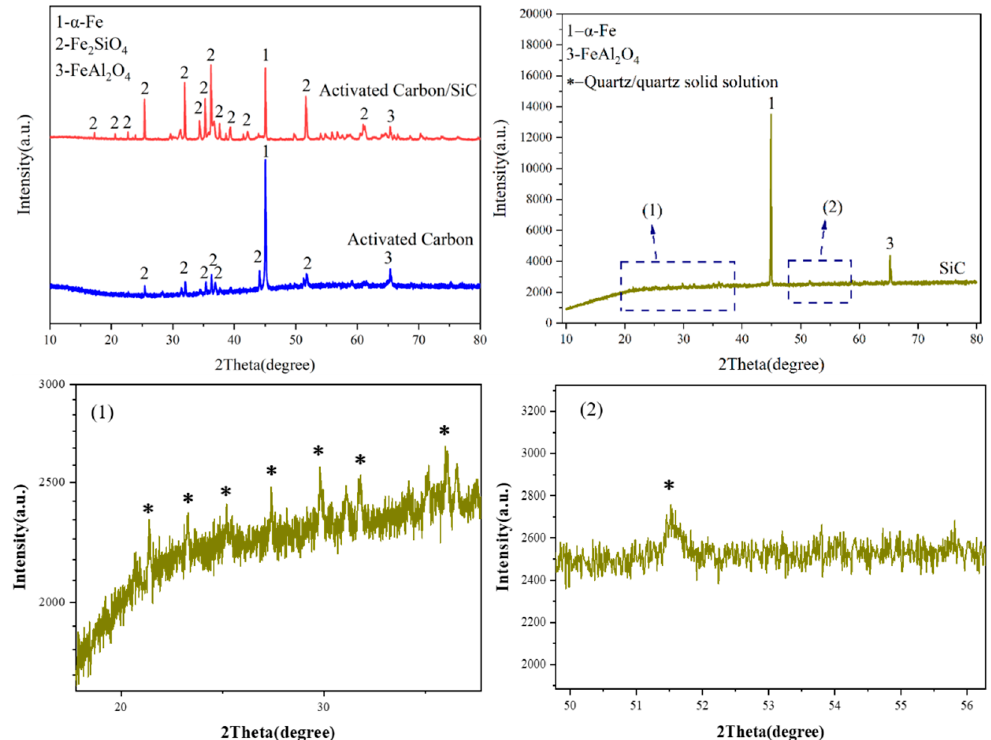
Figure 5. XRD of samples prepared with different microwave susceptors.